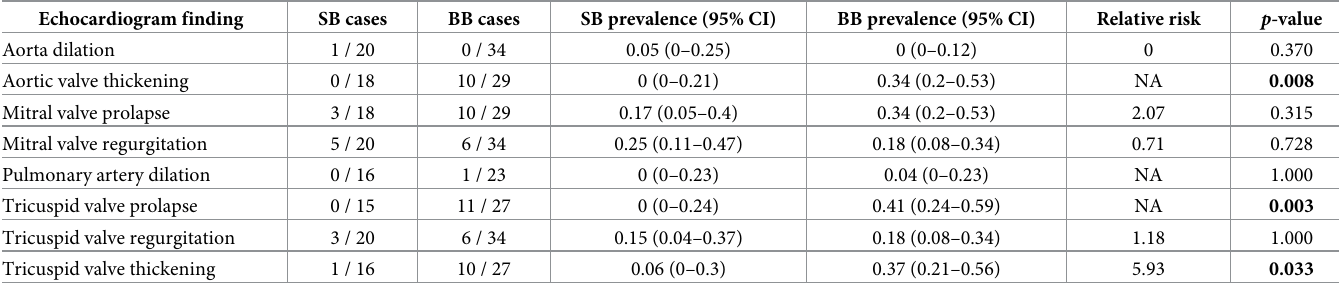
Table 2. Summary of echocardiographic findings of interest. Echocardiogram